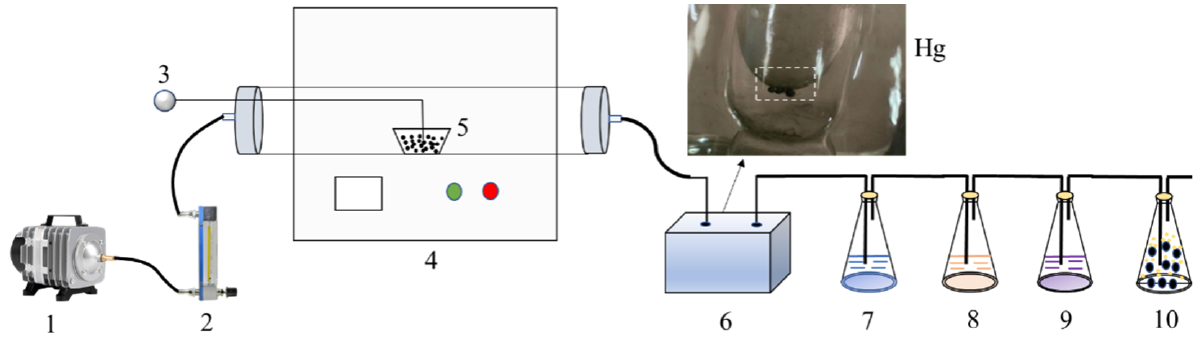
Figure 3. Schematic diagram of microwave/conventional heating equipment. (1) Air pump; (2) Flowmeter; (3) Type-K thermocouple; (4) Furnace (microwave furnace or muffle furnace); (5) Ceramic crucible; (6) Water condenser; (7) 4% KMnO 4 /10% H 2 SO 4 ; (8) Na 2 S solution; (9) NaOH solution; (10) Activated carbon with sulfur powder.